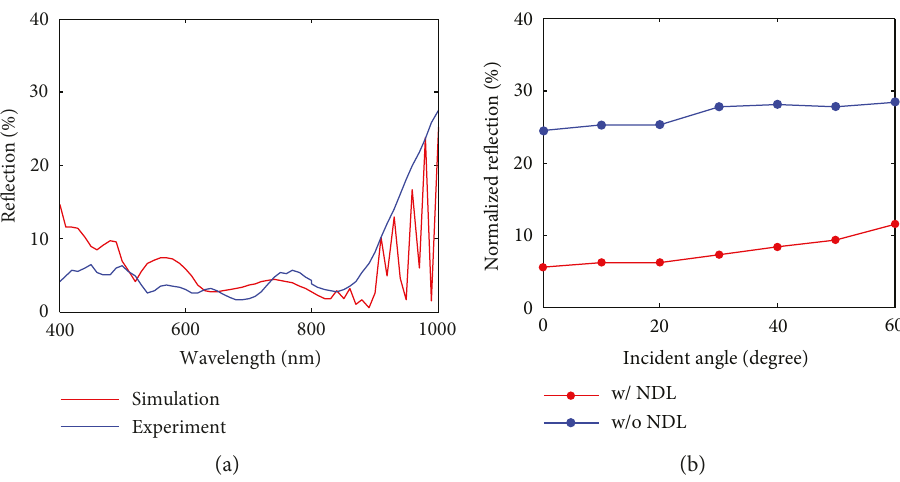
Figure 5: (a) The simulation and experiment results of re fl ection for NDL on 40 μ m thick unpolished c-Si. The incident light is at normal direction with wavelength ranging from 400nm to 1000nm. (b) The dependence of spectral averaged re fl ection (400nm to 1000nm, AM 1.5G) on incident angle for fabricated NDL on unpolished 40 μ m c-Si.